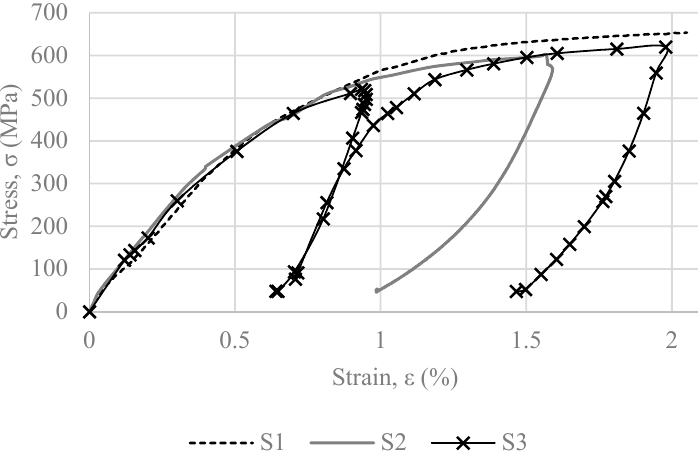
Figure 7. Stress vs. strain curve, specimens S1–S3.